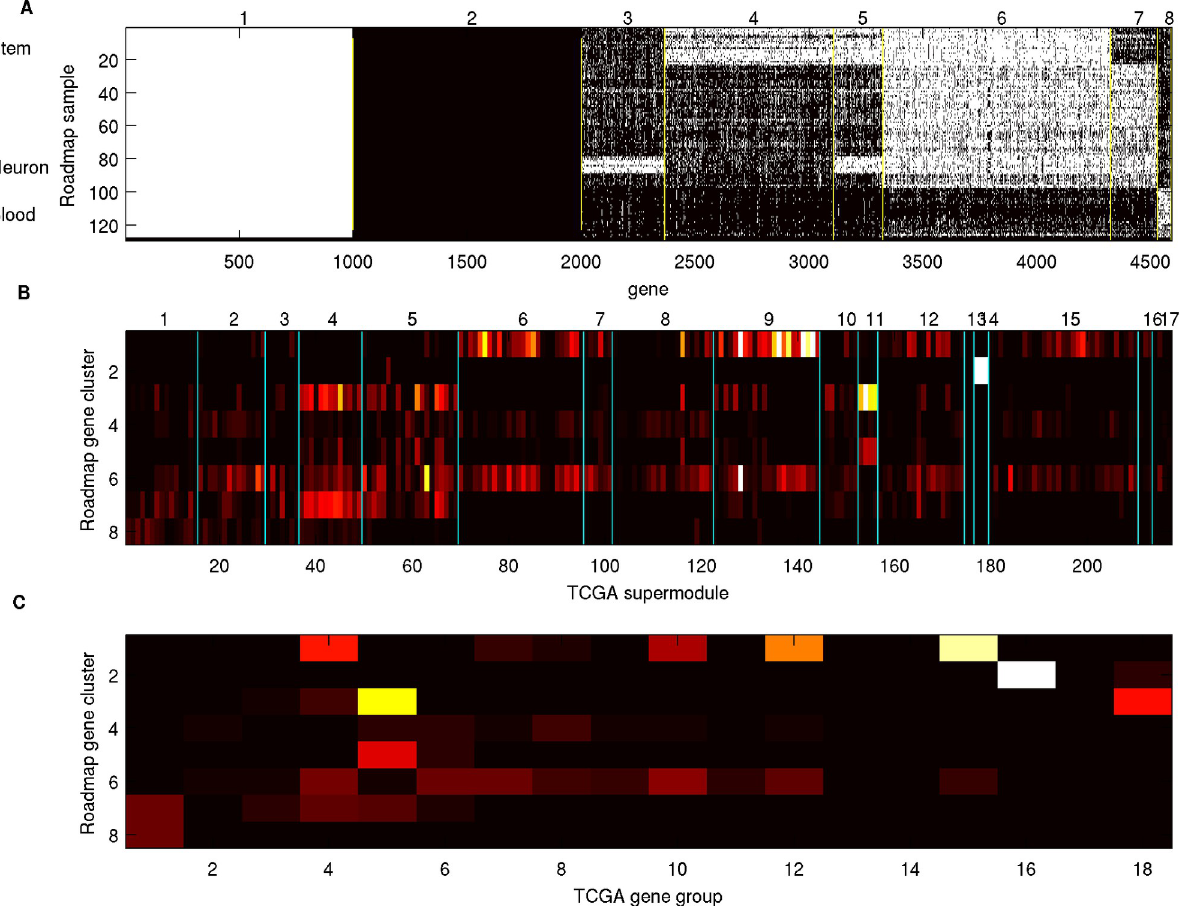
Fig 11. A : Combinatorial patterns of transcriptional regulation states of eight tissue-specific gene clusters from the Roadmap epigenomic data. B : Enrichment p-values of Roadmap gene clusters in TCGA Super Modules. C : Enrichment p-values of Roadmap gene clusters in TCGA Gene Groups. Enrichment p-values of Super Modules and Gene Groups are reported in S12D and S12E